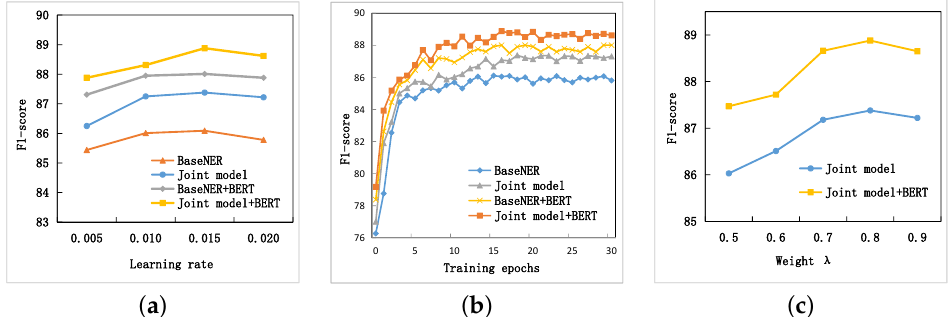
Figure 4. Comparisons between BaseNER and our method on the F1 sensitivity of the hyperparam- eters. All results are generated based on OntoNotes 5.0 (English). ( a ) F1-score vs. Learning rate; ( b ) F1-score vs. Training epochs; ( c ) F1-score vs. the Weight λ